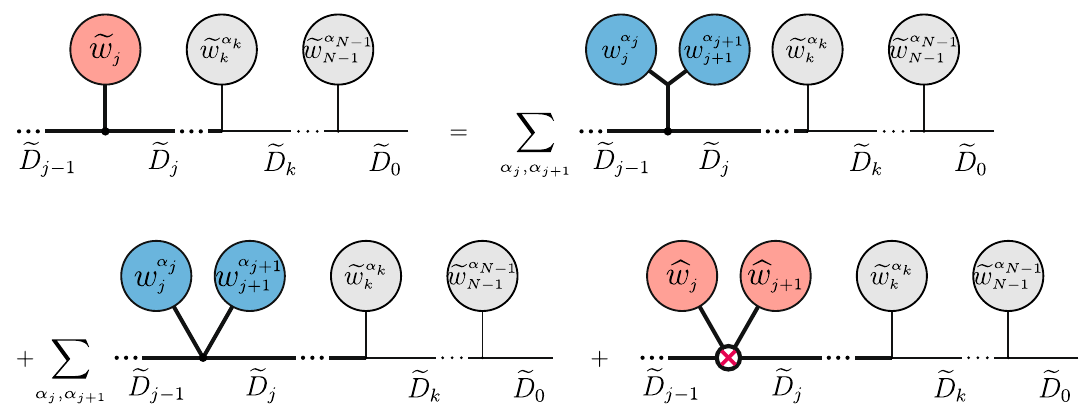
Fig. 8 Diagrammatic representation of formula (88) for the merging rules play an analogous role as the crossed vertex in the pinched open loop (last diagram on the rhs). Besides merging all relevant unpinched of pinched open loops. The first two unpinched diagrams on the rhs, α j α j + 1 combinations α j ,α j + 1 ,alsopossibleunpinchedtopologieswheresome where the generic subtrees w and w are directly connected to the j j + 1 oftheexternallegsin w j and w j + 1 areinterchanged(notshown)should loop propagators (cid:9) D j − 1 and (cid:9) D j , correspond to the first term on the rhs be of (88). The corresponding triple or quartic vertices of the Feynman